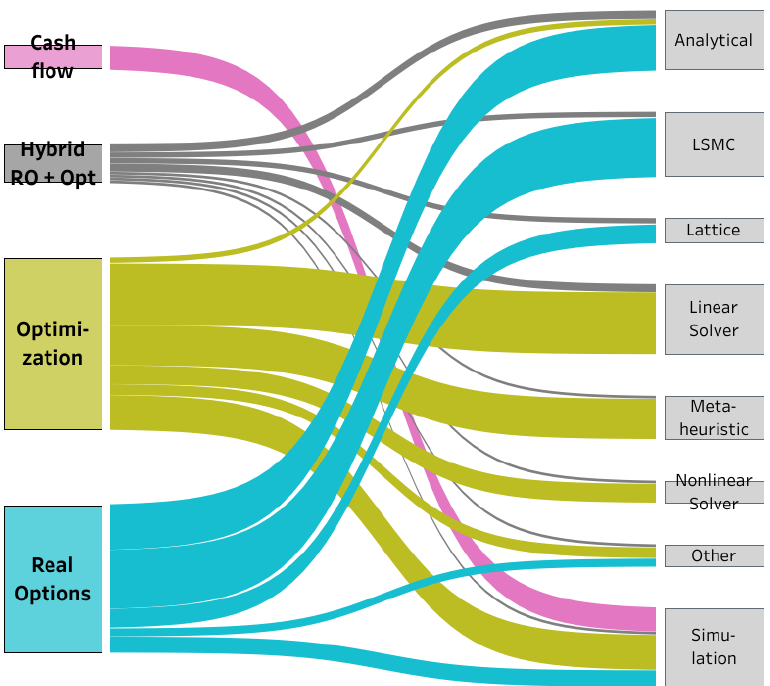
Figure 8. Sankey flowcharts of problem formulations ( left ) to solution methods ( right ). The width represents the article count. Self-elaboration based on [159].